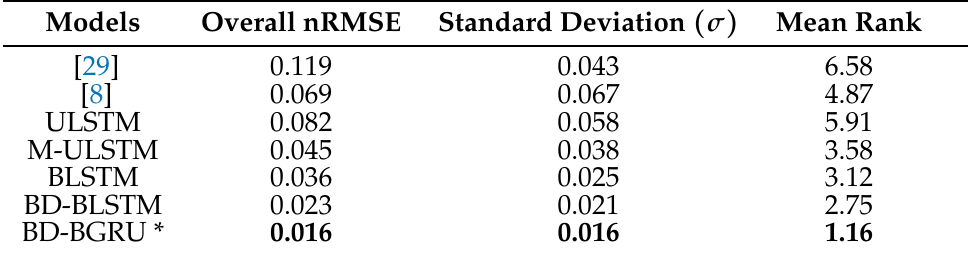
Table 10. Overall performance summary of the forecasting